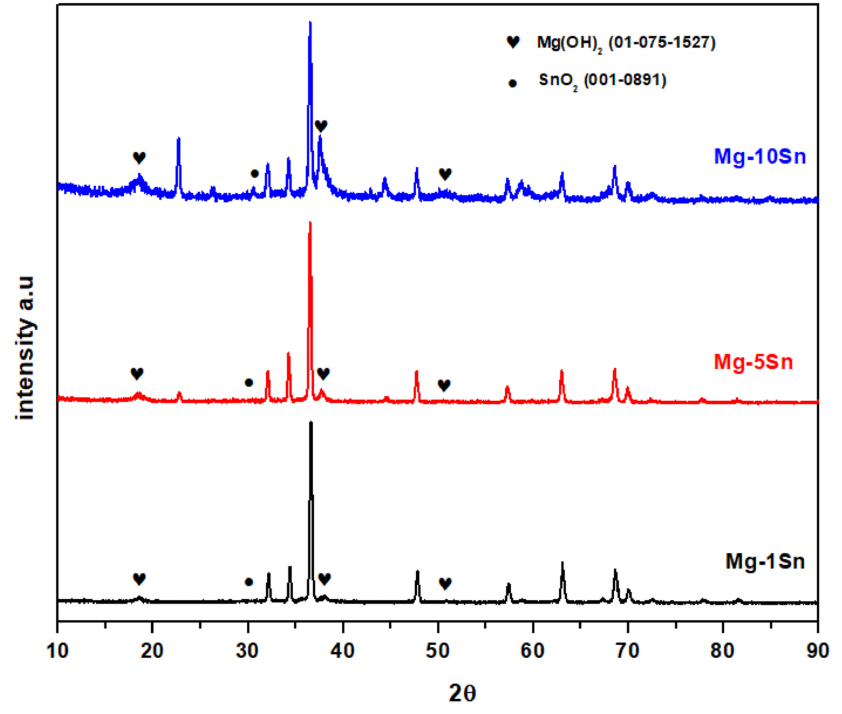
Figure 8. XRD spectra of Mg-Sn alloys after immersion